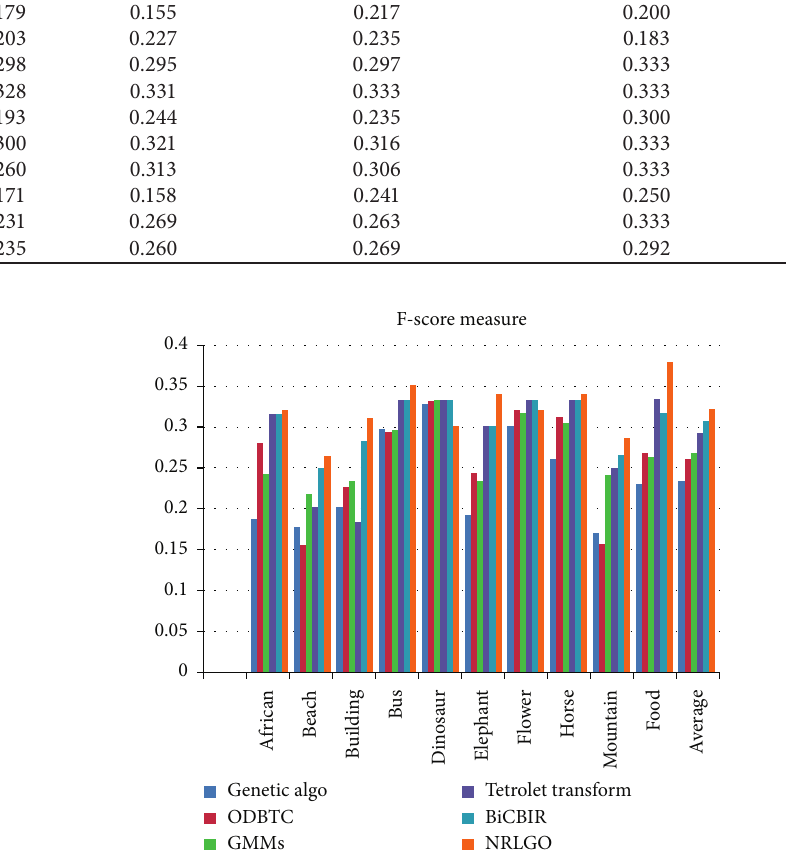
Figure 9: F-score is calculated for each category in Corel 1k and compared with the state-of-the-art